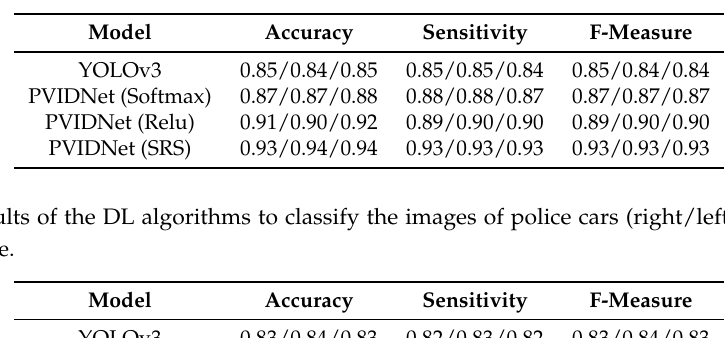
Table 7. Results of the DL algorithms to classify the images of the ambulances (right/left/front) in the training phase.